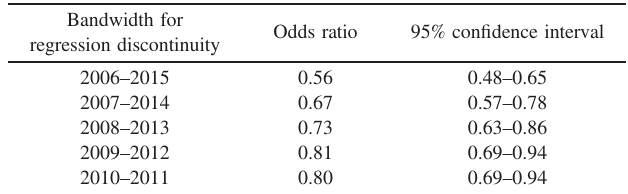
Table 2. Regression discontinuity analyses comparing the odds of undergoing computed tomography before versus after the Fukushima Daiichi Nuclear Power Plant